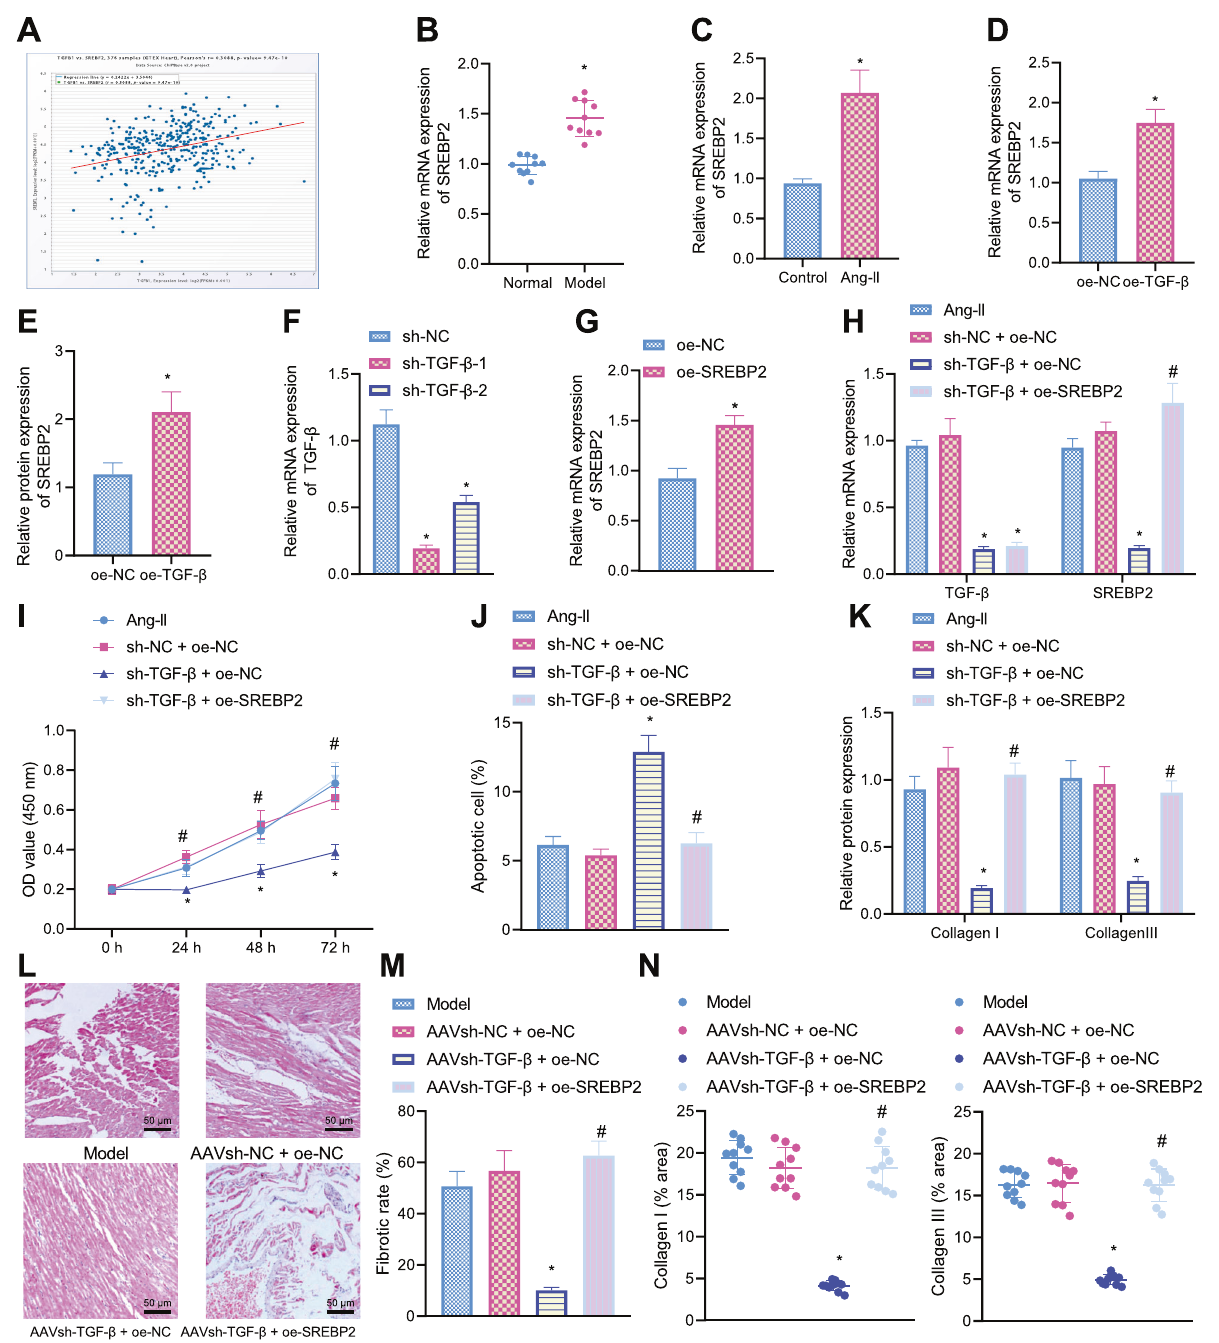
Fig. 4 TGF- β upregulates the expression of SREBP2 to induce atrial fi brosis. A Correlation between TGF- β and SREBP2 in heart tissues analyzed by the Chipbase v2.0 database ( r = 0.3088, p- value = 9.47e − 10). B RT-qPCR detection of SREBP2 expression in atrial tissues of normal and Ang II-treated mice. C RT-qPCR detection of SREBP2 expression in control and Ang II-induced HL-1 cells. D RT-qPCR detection of SREBP2 expression in HL-1 cells treated with oe-SREBP2. E Western blot analysis of SREBP2 protein in HL-1 cells treated with oe-SREBP2. F RT-qPCR detection of TGF- β expression in HL-1 cells treated with sh-TGF- β -1 or sh-TGF- β -2. G RT-qPCR detection of SREBP2 expression in HL-1 cells treated with oe-SREBP2. H RT-qPCR detection of SREBP2 and TGF- β expression in HL-1 cells treated with sh-TGF- β or combined with oe- SREBP2. I CCK-8 detection of cell viability in HL-1 cells treated with sh-TGF- β or combined with oe-SREBP2. J TUNEL detection of apoptosis of HL-1 cells treated with sh-TGF- β or combined with oe-SREBP2. K Western blot analysis of collagen I and collagen III proteins in HL-1 cells treated with sh-TGF- β alone or in combination with oe-SREBP2. L HE staining of pathological changes of atrial tissues of Ang II-induced mice treated with sh-TGF- β or combined with oe-SREBP2. M Masson ’ s trichrome staining of atrial fi brosis degree in Ang II-induced mice treated with sh-TGF- β or combined with oe-SREBP2. N IHC analysis of collagen I and collagen III proteins in atrial tissues of Ang II-induced mice treated with sh-TGF- β or combined with oe-SREBP2. * p < 0.05, compared with the normal mice, control HL-1 cells, Ang II-induced HL-1 cells treated with sh- NC, oe-NC or sh-NC + oe-NC or Ang II-induced mice treated with sh-NC + oe-NC. # p < 0.05, compared with the Ang II-induced HL-1 cells or mice treated with sh-TGF- β + oe-NC. All experiments were repeated three times independently . n = 10 for mice in each group.